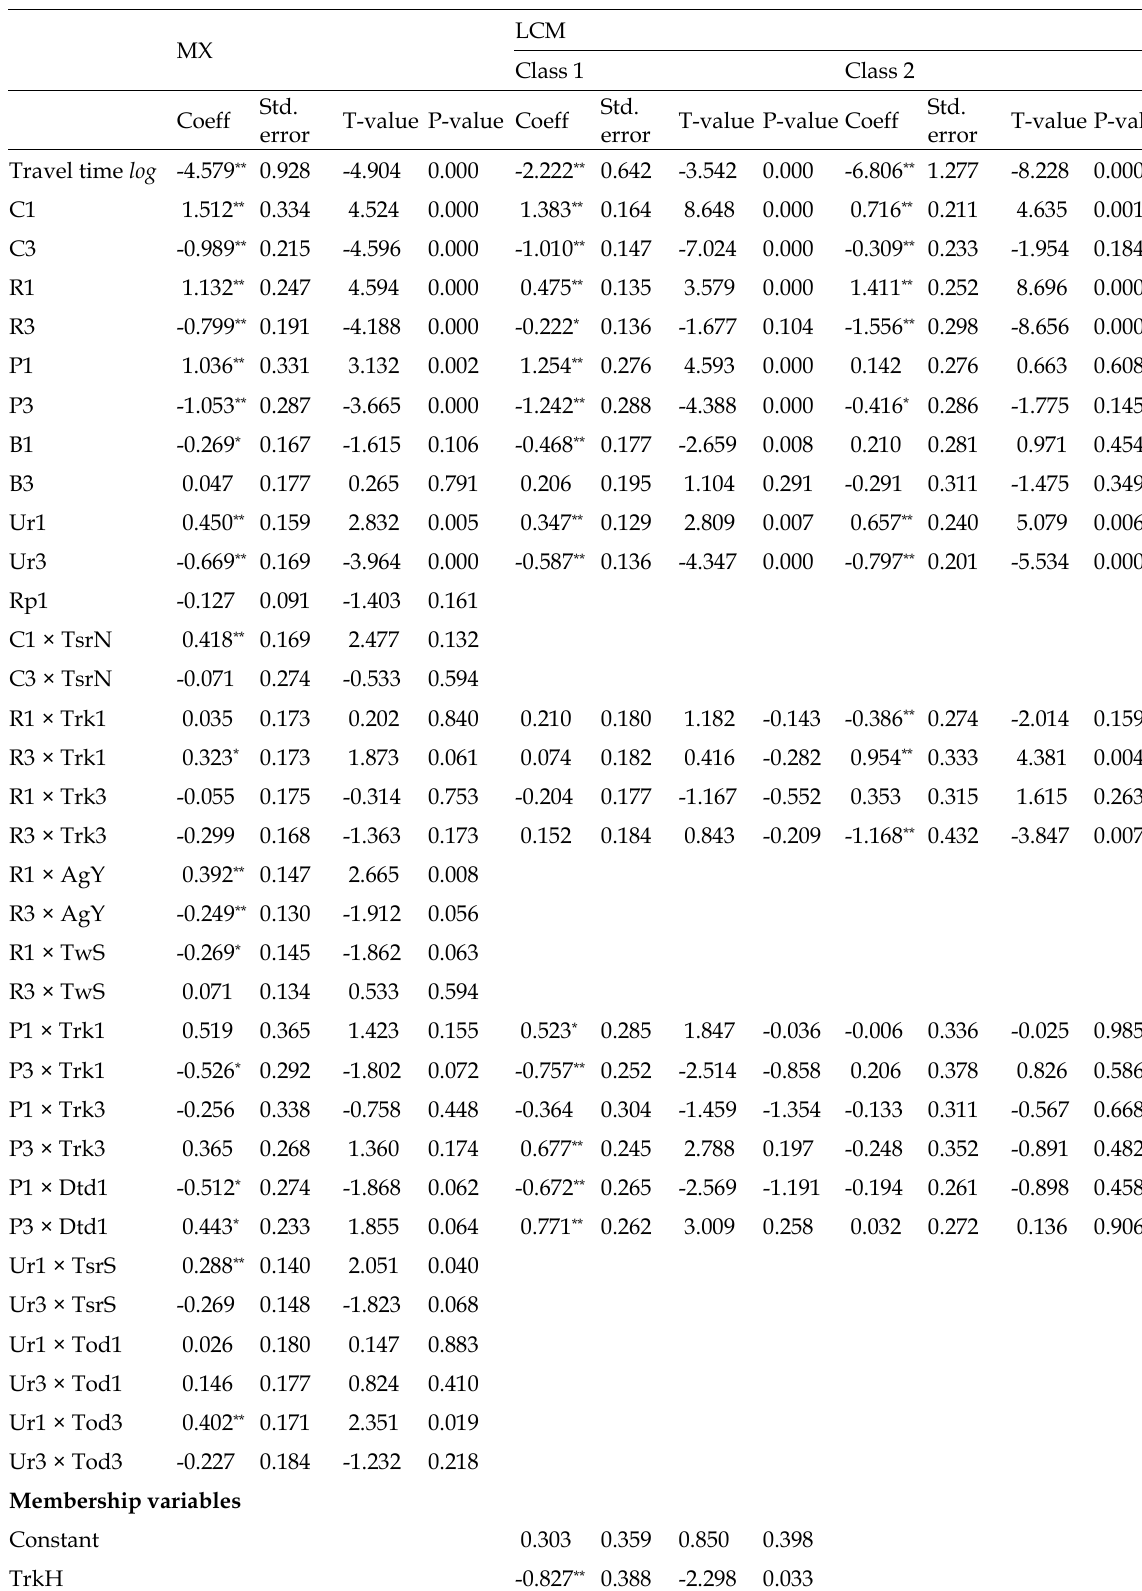
Table 5 Estimation results of ML model and